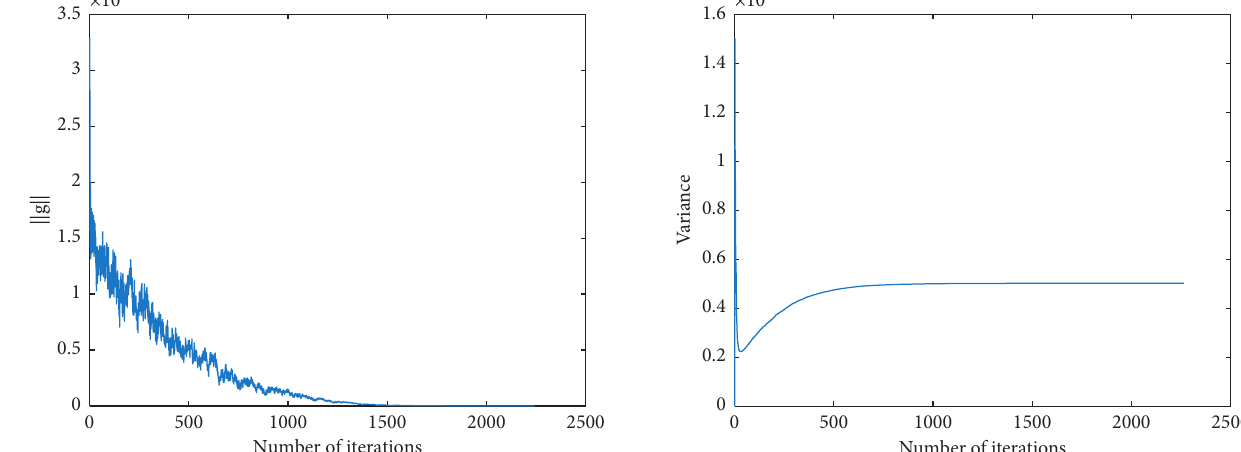
Figure 7: Changes in the variance of SGD algorithm.